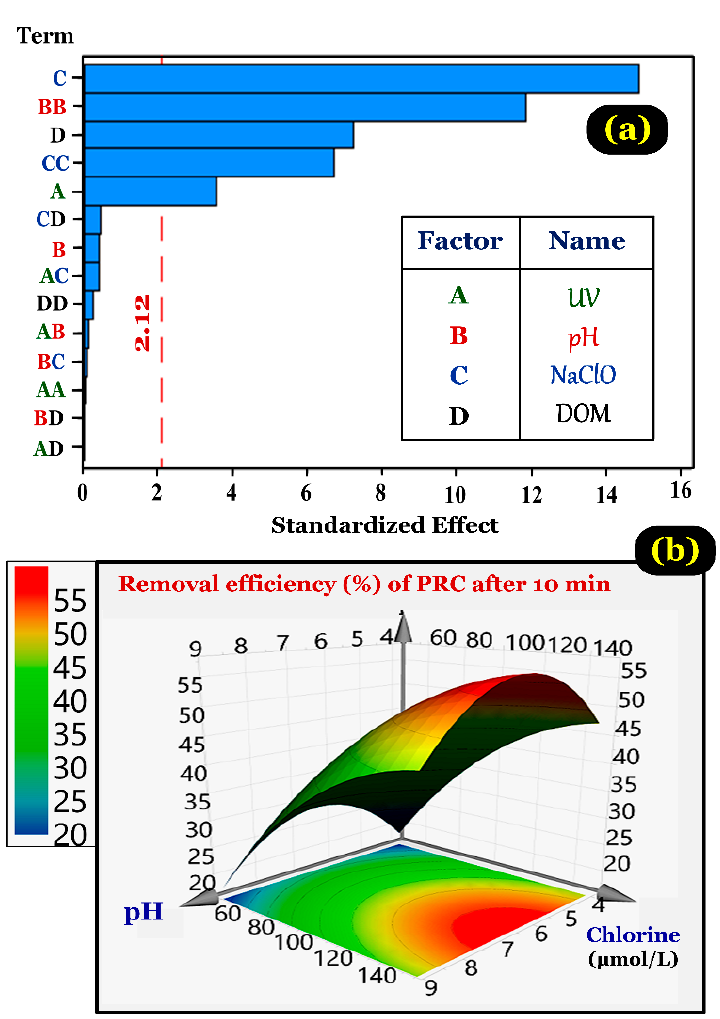
Figure 8. ( a ) Pareto chart of standardized effects (response is removal efficiency, α = 0.05); and ( b ) typical response surfaces and contour plots from central composite circumscribed design showing the interactive effect of pH and NaOCl on the removal efficiency of PRC in water.